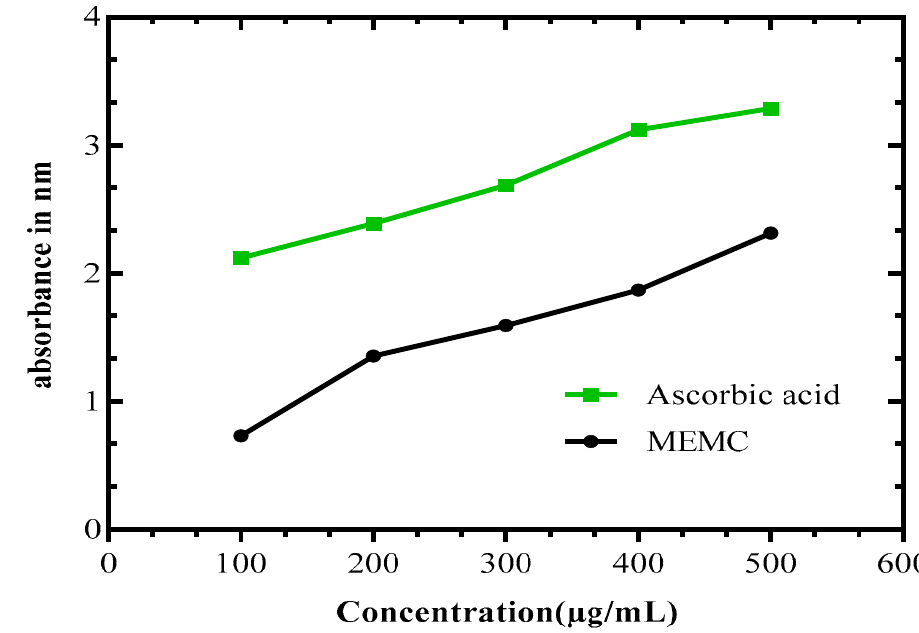
Figure 1. Reducing power capacity of MEMC compared with the reference standard ascorbic acid. MEMC, methanol leaf extract of Molineria capitulata.